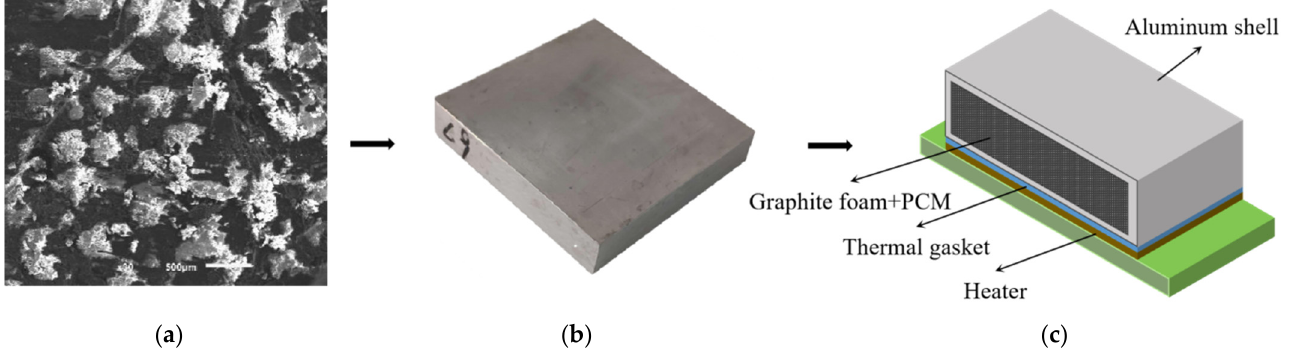
Figure 4. Higher alcohol/graphite foam-based heat sink. ( a ) Micrograph of higher alco-hol/graphite foam. ( b ) Encapsulated heat sink. ( c ) Experimental apparatus.